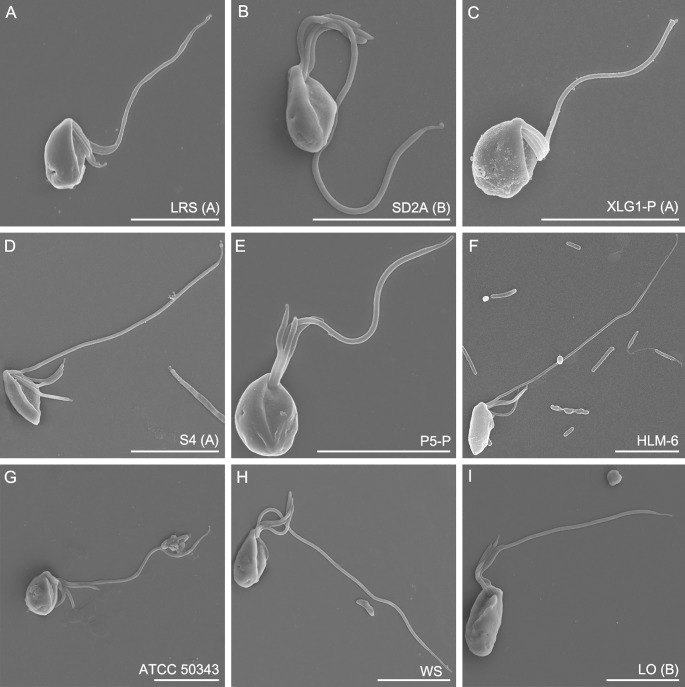
Scanning electron micrographs of Percolomonas cosmopolitus-like strains.(A) Strain LRS (B) Strain SD2A. (C) Strain XLG1-P. (D) Strain S4. (E) Strain P5-P. (F) Strain HLM-6 = Percolomonas lacustris. (G) ATCC 50343. (H) Strain WS. (I) Strain LO. The order of strains in Fig 3 is the same as that in Fig 2 and Table 1. All scale bars represent 5 μm.